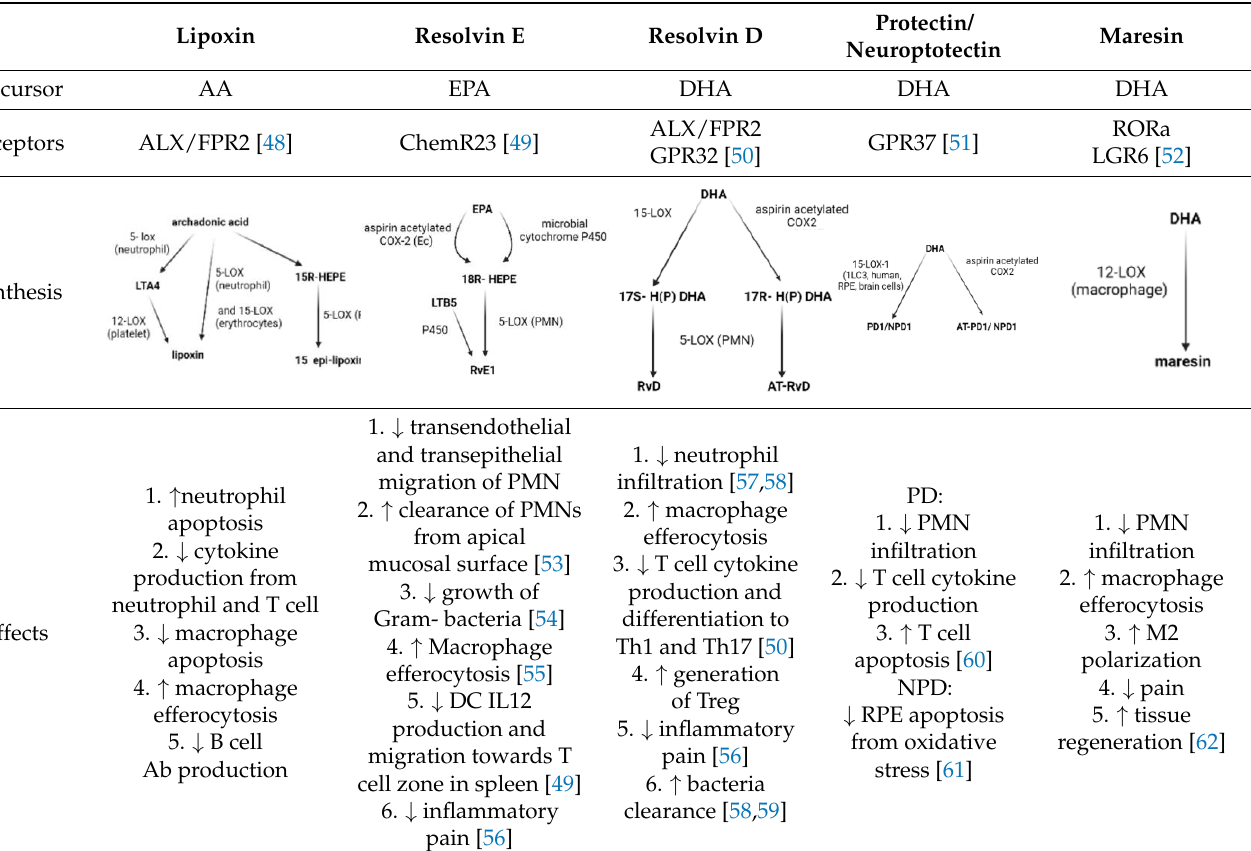
Table 1. The role of the different specialized pro-resolving mediators in the resolution.